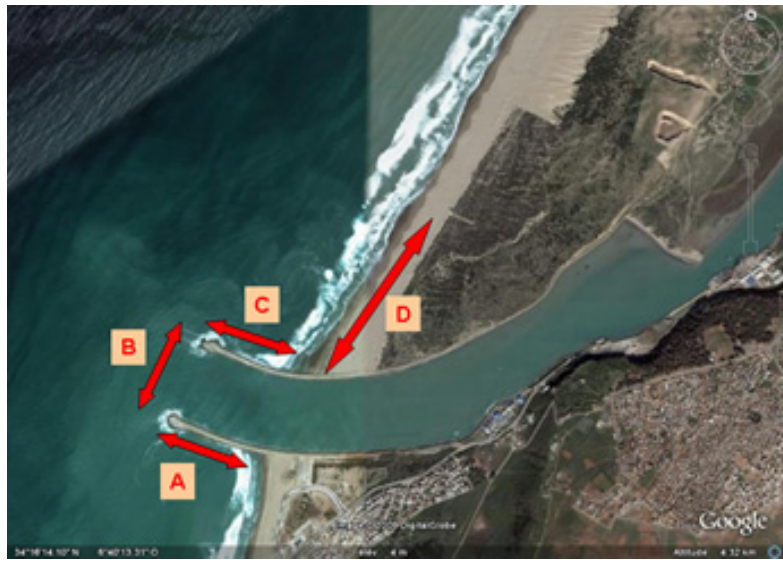
Figure 5. The different zones subject to analysis: stress on structures (A, C), B-agitation in the river outlet (B), littoral erosion (D).